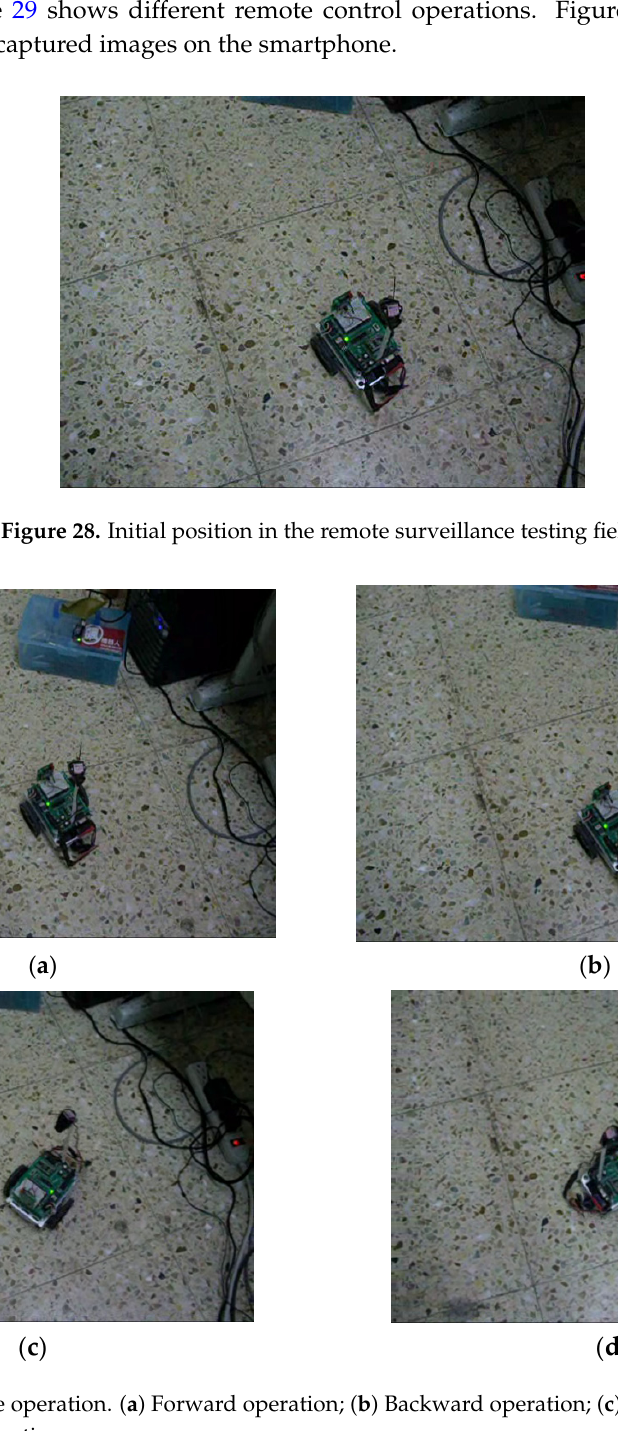
Figure 27. Captured images on PC screen. ( a ) Captured image on PC screen at Figure 26a position; ( b ) Captured image on PC screen at Figure 26b position; ( c ) Captured image on PC screen at Figure 26c position; ( d ) Captured image on PC screen at Figure 26d position; ( e ) Captured image on PC screen at Figure 26e position; ( f ) Captured image on PC screen at Figure 26f position; ( g ) Captured image on PC screen at Figure 26g position; ( h ) Captured image on PC screen at Figure 26h position.